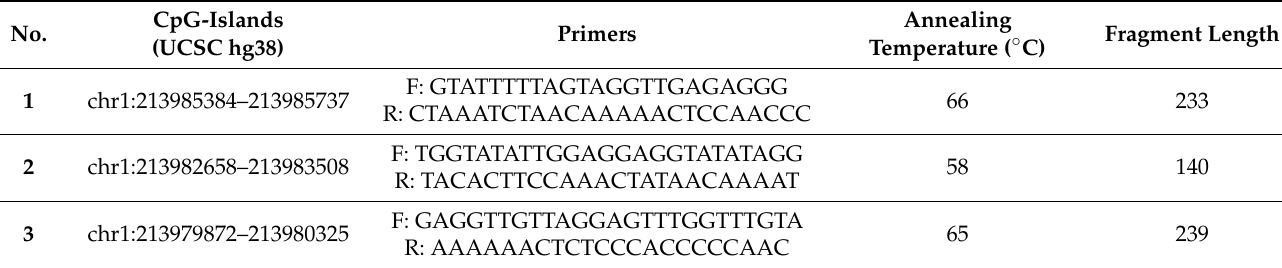
Table 2. The sequence of primers for bisulfite sequencing